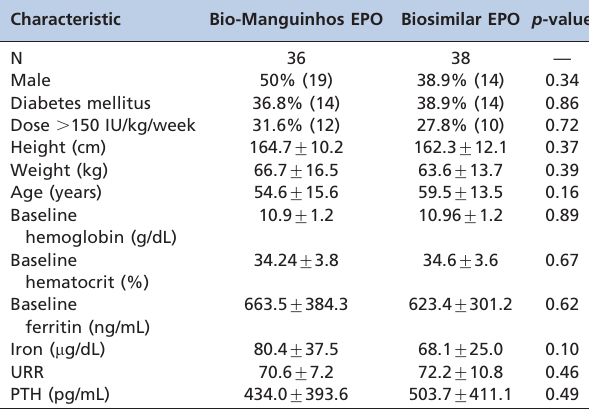
Table 1 - Sample profile (by study group).